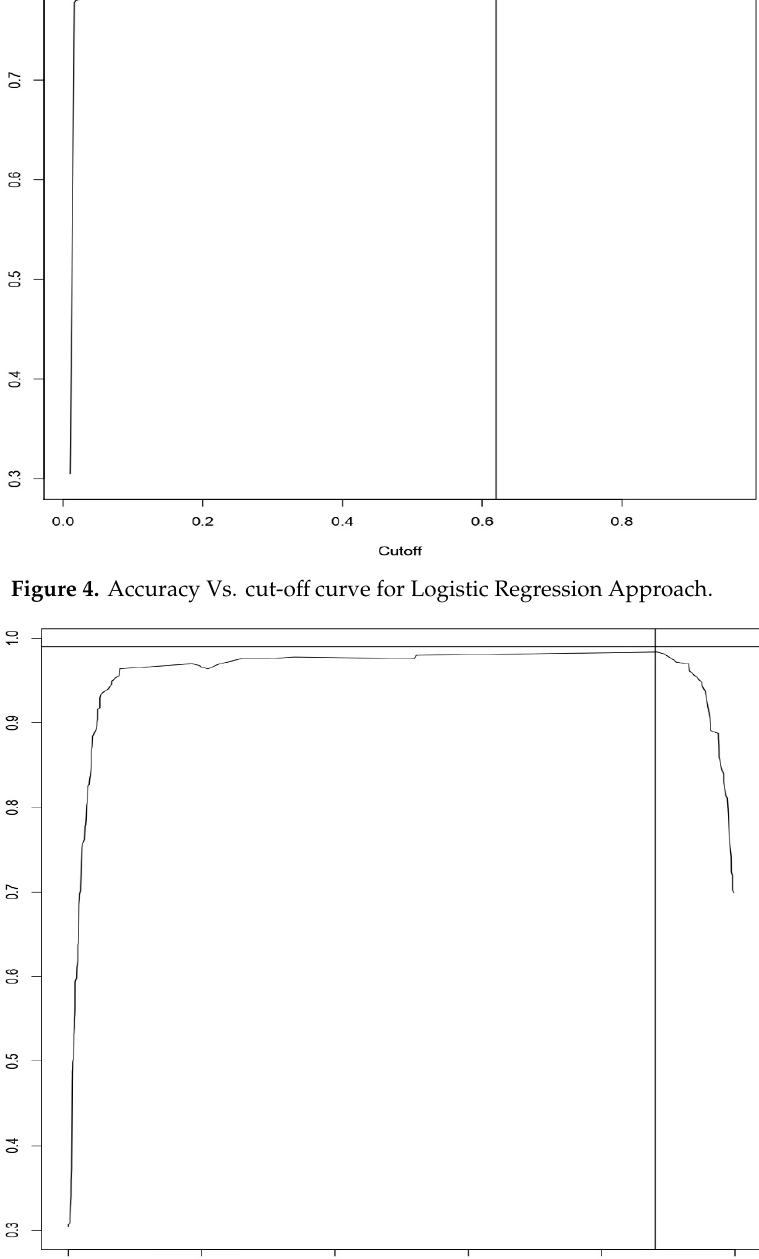
Figure 5. Accuracy Vs. cut-off curve for Random Forest Approach.